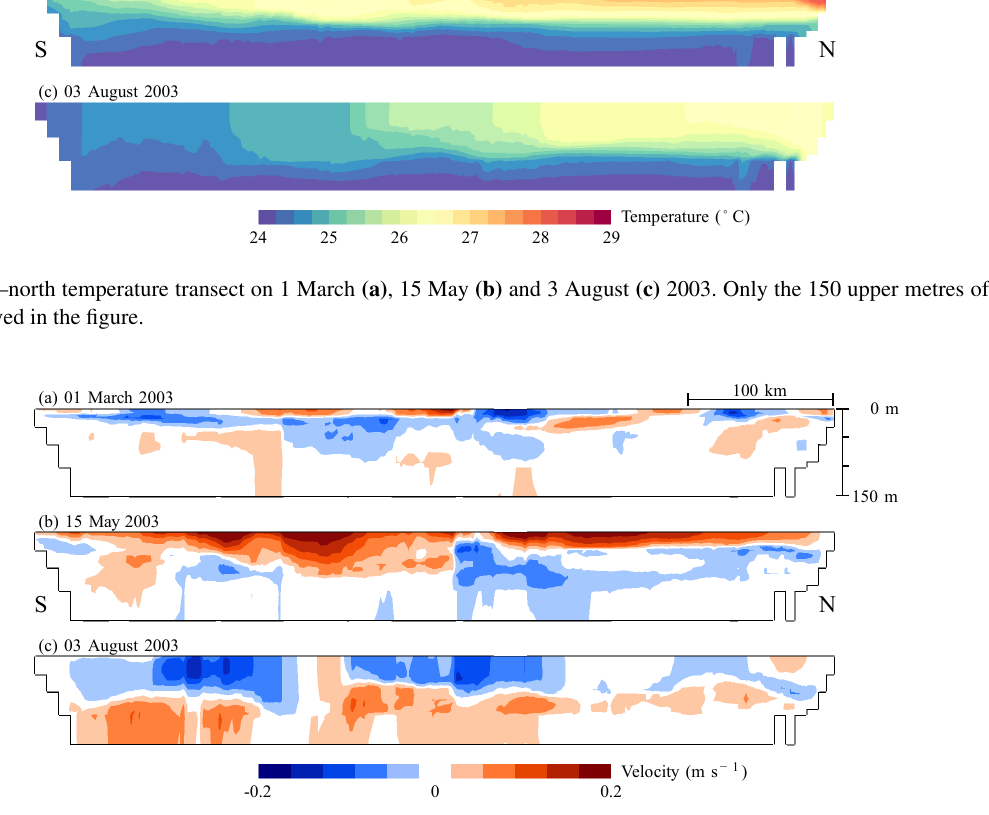
Figure 18. South–north velocity transect on 1 March (a) , 15 May (b) and 3 August (c) 2003. Only the 150 upper metres of the vertical profile are displayed in the figure. A positive value indicates northward current.